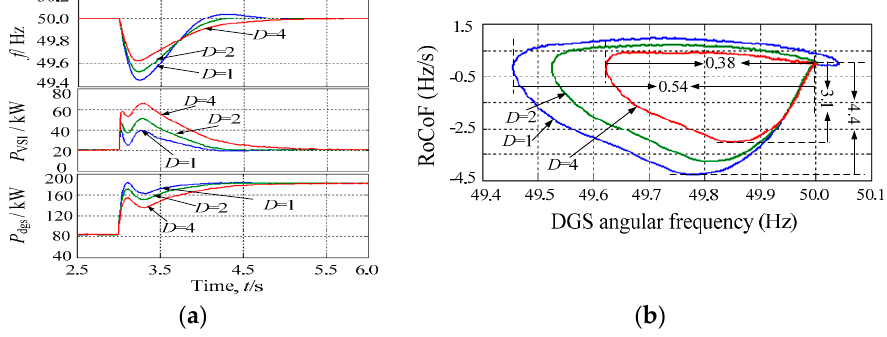
Figure 14. ( a ) Effects of the different values of virtual damping and zero virtual inertia on an active power transient; ( b ) Angular frequency-acceleration curves of DGS with virtual damping control loop.